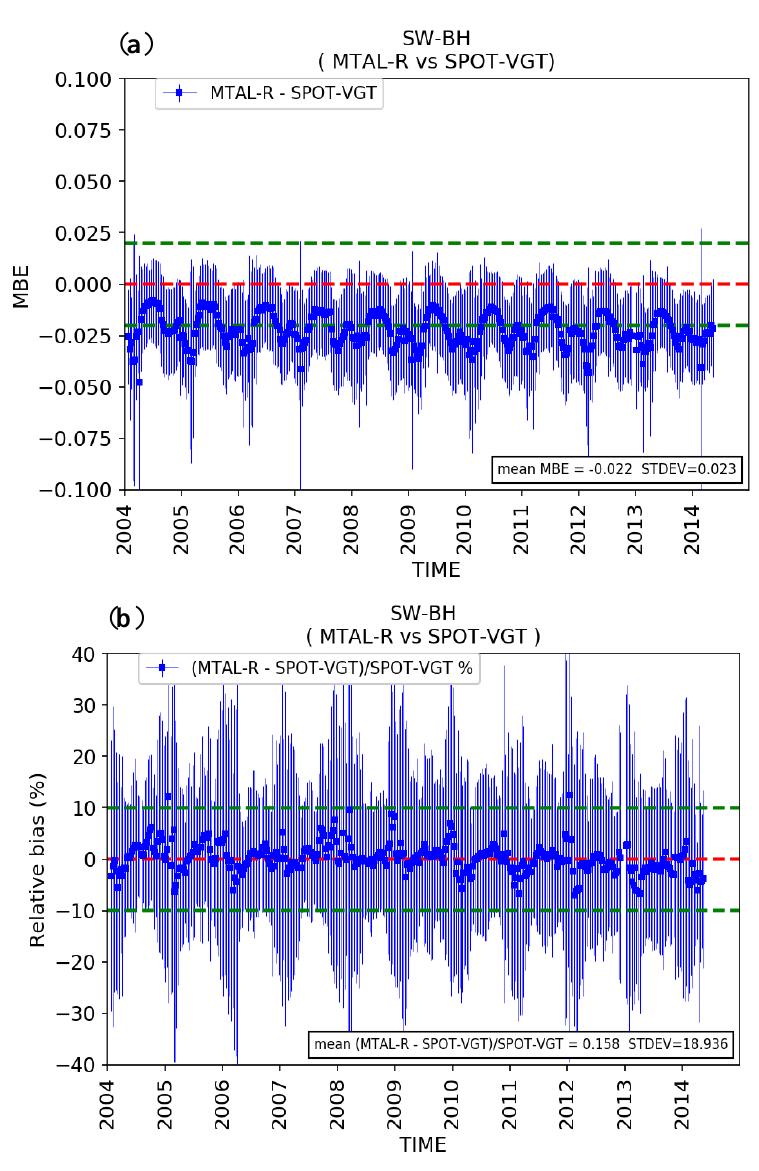
Figure 5. Time series of the mean bias and mean relative bias of MTAL-R versus SPOT-VGT for all 337 AERONET reference sites located in Africa, Europe, and South America, when MTAL-R is ( a ) less than 0.15 and ( b ) greater than 0.15. The green dotted lines in the plot correspond to the product requirement values. The blue vertical lines represent the standard deviation for each date.